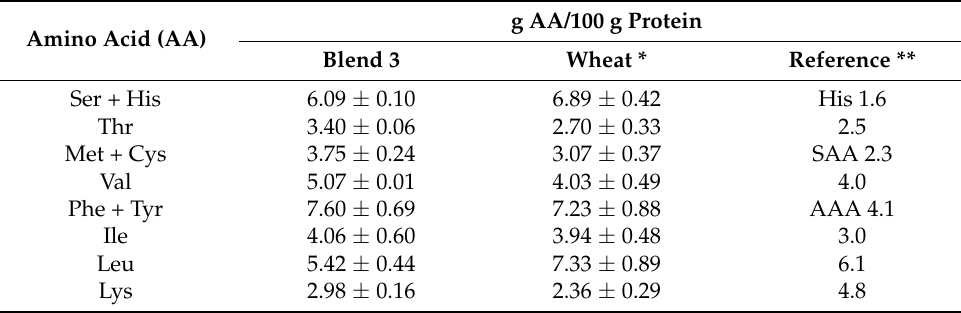
Table 7. Indispensable amino acid profile of blend 3 protein and the reference pattern.